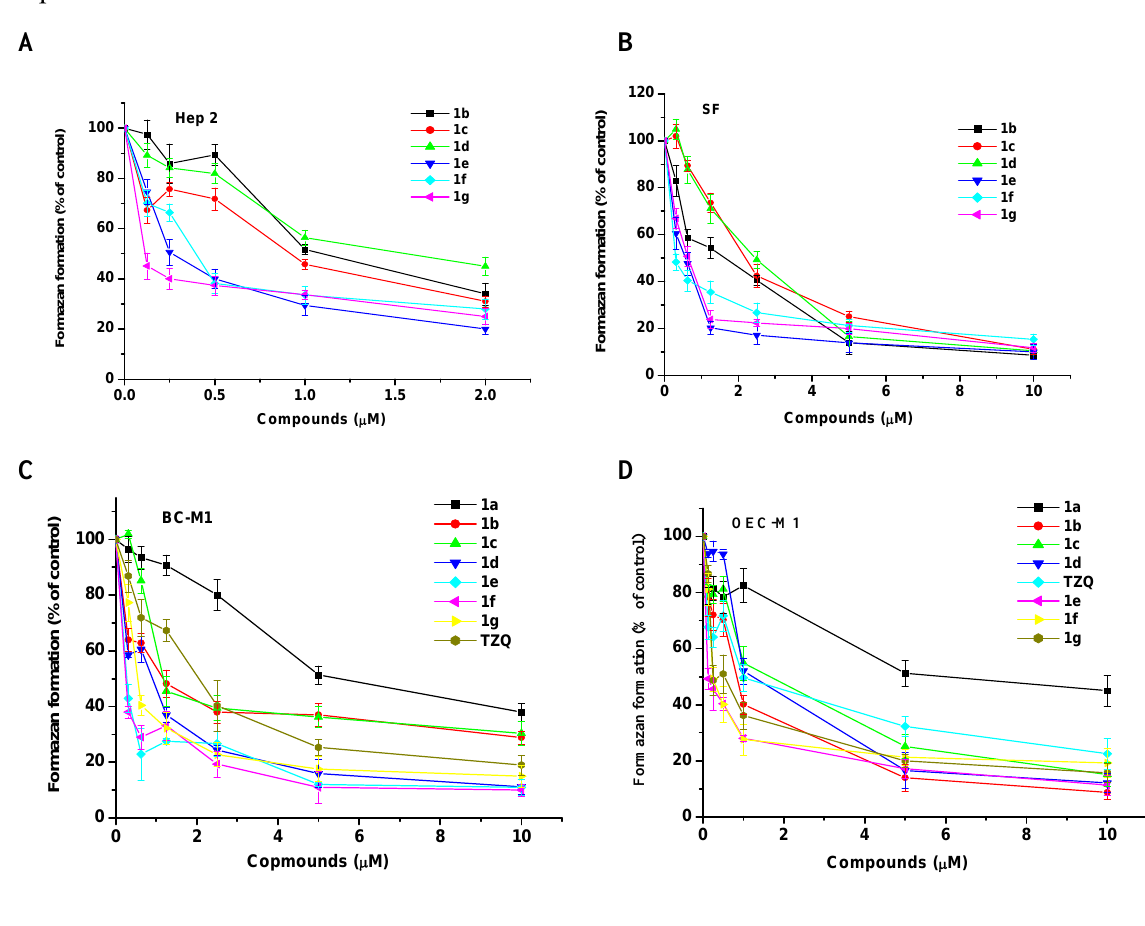
Figure 2. Compounds 1b to 1f inhibited the proliferation of cell lines Hep 2 (A) and SF (B), 1a to 1f compounds and TZQ inhibited the proliferation of cell lines OEC-M1 (C) and BC-M1 (D) that were seeded for 18 hr before the addition of two compounds with various concentrations. The MTT assay was used to determine the cell viability after an additional 24 hr of culture. Data were from triplet wells and are representative of three separate